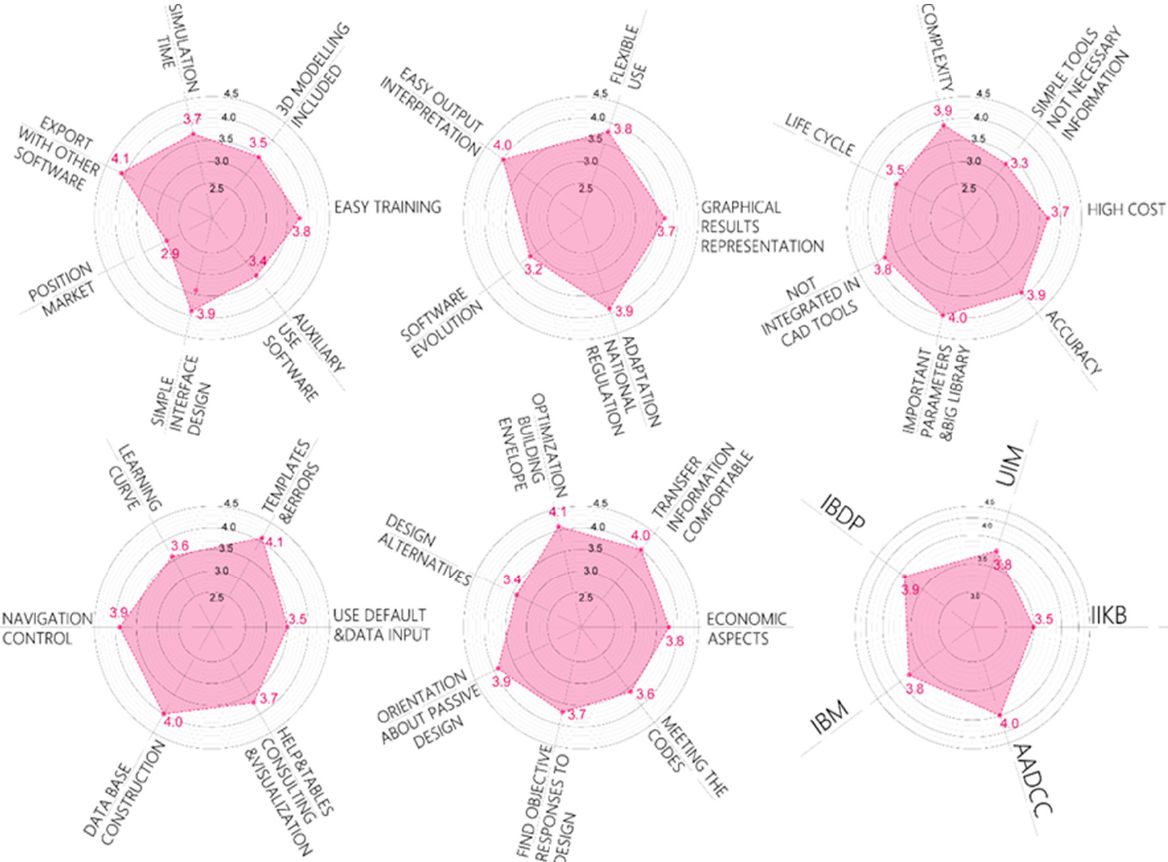
Figure 9. BPSTs selection criteria.